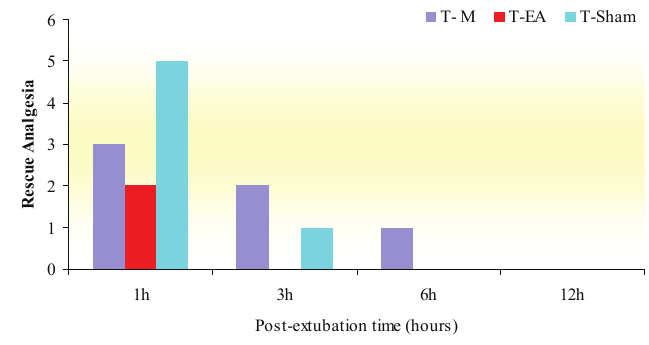
FIGuRE 2 – Number of dogs that required rescue analgesia at various times after tracheal extubation.